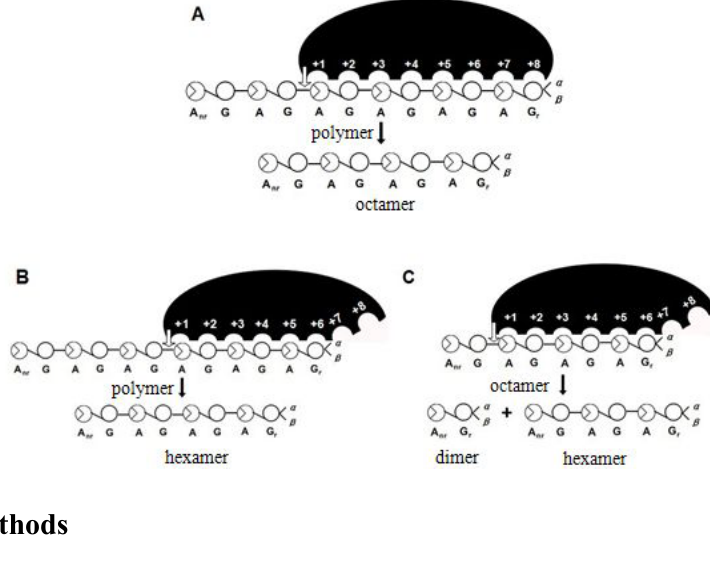
Figure 9. Degradation mode of κ -carrageenase. The recognition units of the enzyme are κ-neocarraoctaose ( A ) and κ-neocarrahexaose ( B ); and then κ-neocarraoctaose is broken into κ-neocarrabiose and κ-neocarrahexaose ( C ). The end-products of the κ-carrageenase are κ-neocarrabiose and